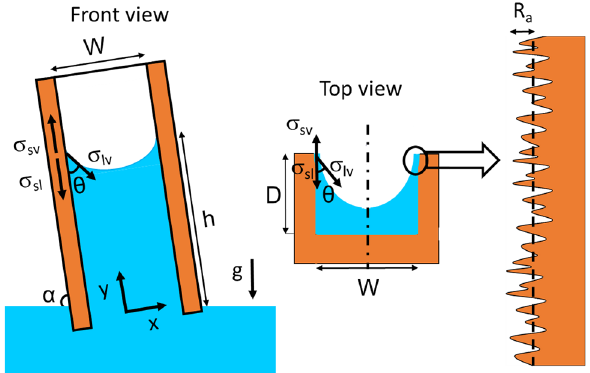
Figure 1. Top and front view of capillary rise, h , in a rough micro-groove with width of W and depth of D . Our previous model 13 is extended to include the effects of surface roughness. Dash line shows the mean surface line. α denotes an inclination angle of the capillary